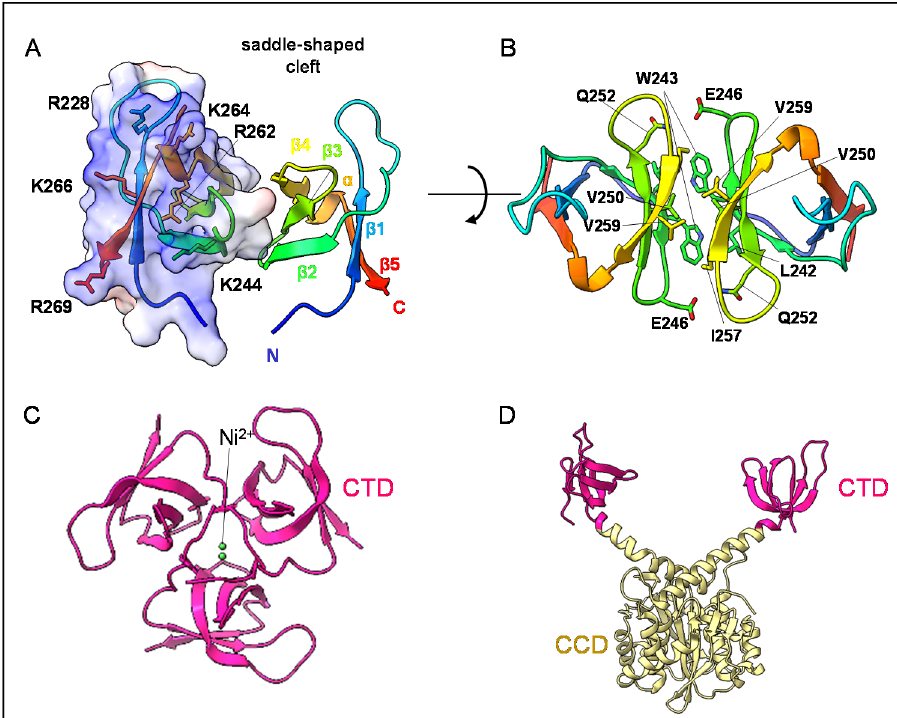
Figure 3. Oligomeric forms of HIV-1 CTD. ( A ). HIV-1 CTD dimer in solution (PDB: 1IHV; [33]). The surface representation of the right monomer of the CTD shows its electrostatic charge distribution. A basic patch is observed (R228, K244, R262, K264, K266, R269) near a saddle-shaped groove (R231, K258), indicated with a dashed line (grey). The left monomer is shown in a cartoon depiction and coloured in rainbow colours from the N- to C-terminus in order to emphasize the SH3-like fold. ( B ). Interacting residues at the canonical CTD-CTD dimeric interface are shown by lines and labelled (L242, W243, E246, Q252, I257). ( C ). Crystal structure of a trimeric CTD (PDB: 6T6J; [37]) harbouring an N-terminal polyhistidine-tag that coordinates Ni2+ ions (in green) along a three-fold molecular axis. ( D ). HIV-1 two-domain CCD-CTD crystal structure (PDB: 1EX4, [21,38]). The CCD-CTD protein fragment acquires a Y-shape dimeric conformation. The CCDs dimerized, and the respective CTDs (in dark pink) are at the end of the two helical CCD linkers (in pale yellow). HIV-1 IN CTD220-270 shows nonspecific DNA-binding properties and contains many basic residues [31,32,39–41]. The dimer exhibits a saddle-shaped groove delineated